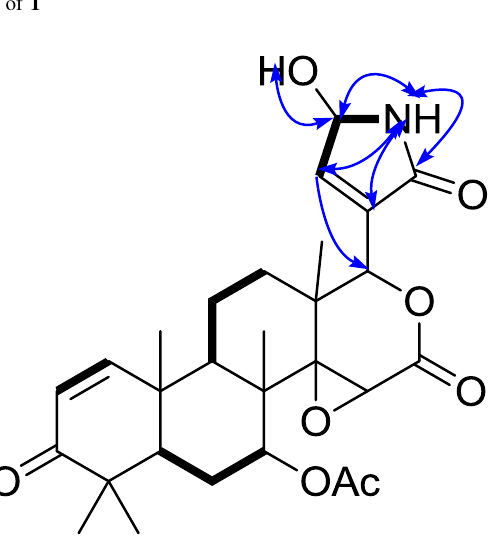
Fig. 2 Key HMBC (H C), 1 H- 1 H COSY (